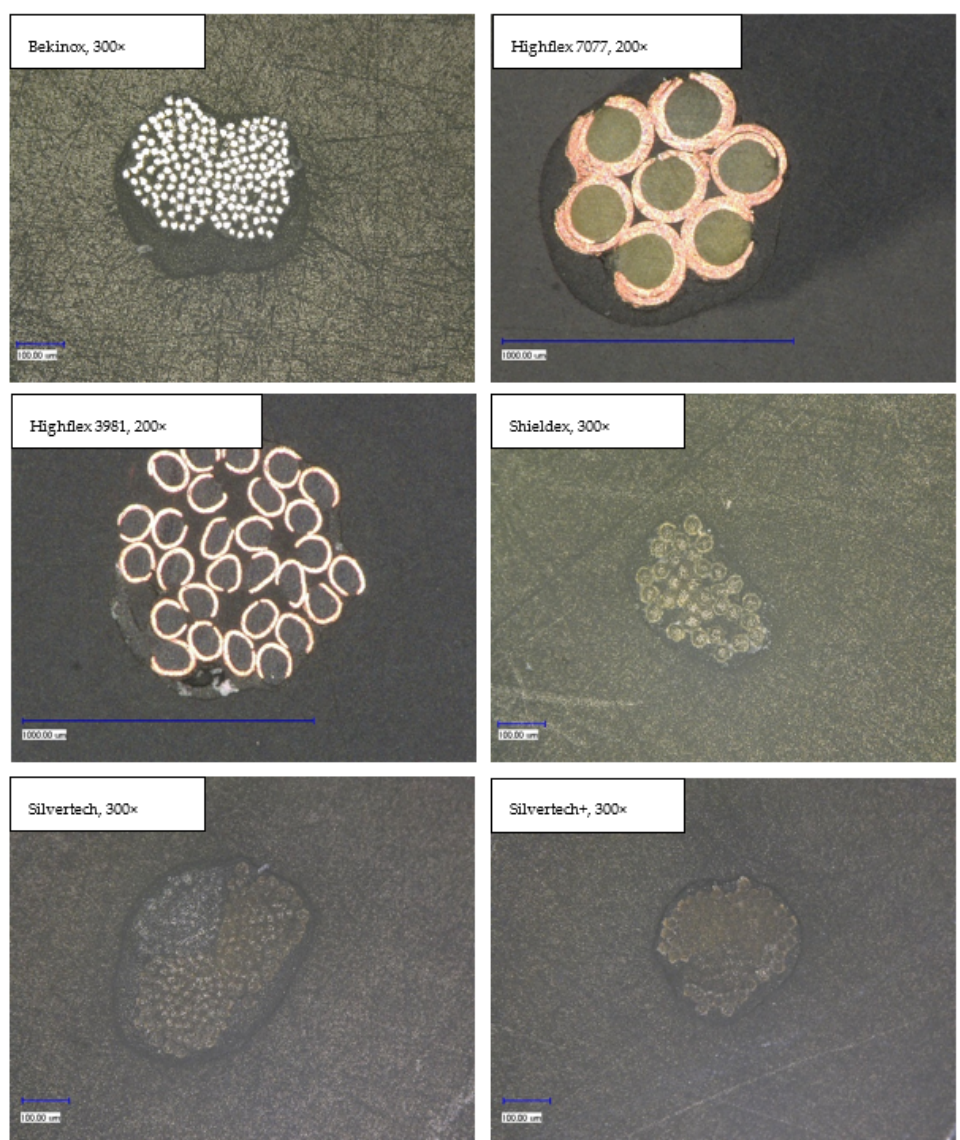
Figure 7. Cross-sectional view of coated samples showing the sheathing of substrates with the coating film.